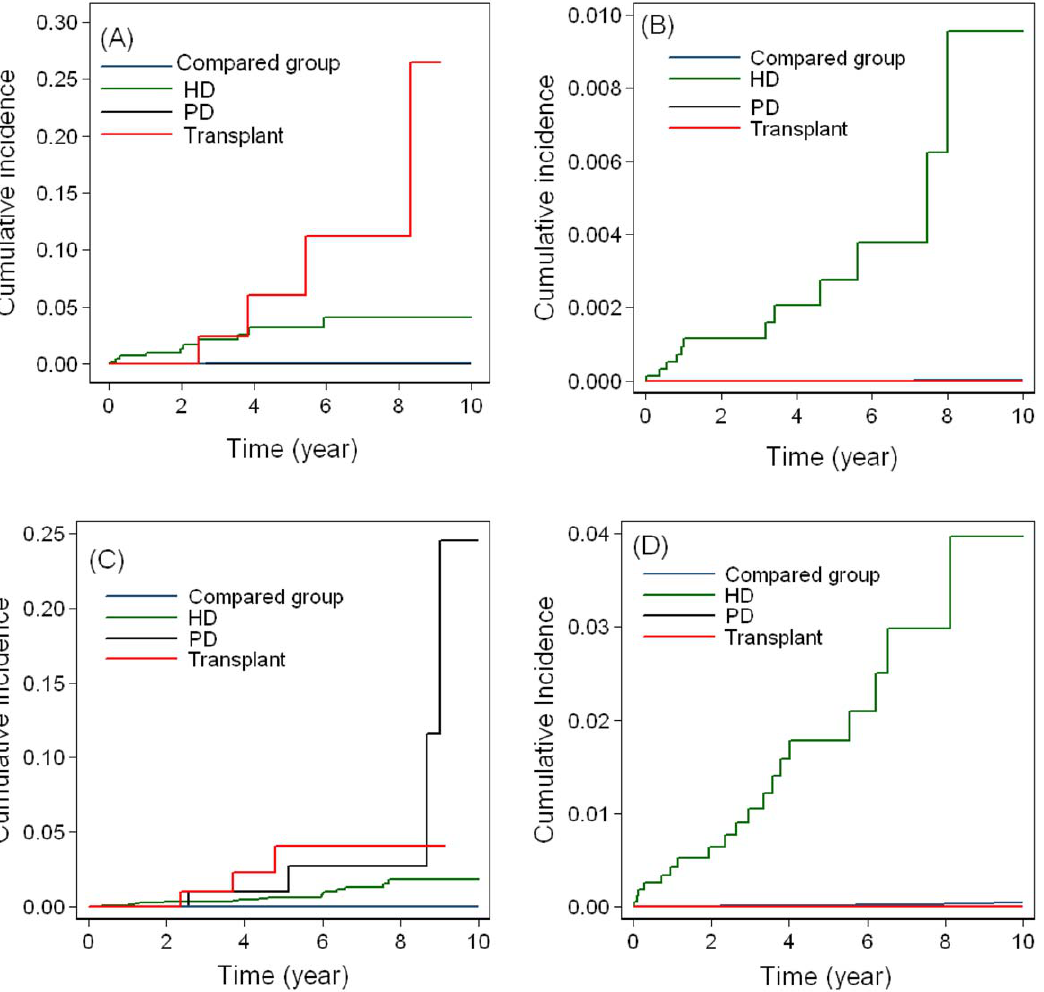
Figure 2. Cumulative incidence of cancer by sex after adjusting for age, hypertension, hyperlipidemia, and diabetes. (A) RCC in female, (B) RCC in male, (C) UC in female, (D) UC in male.